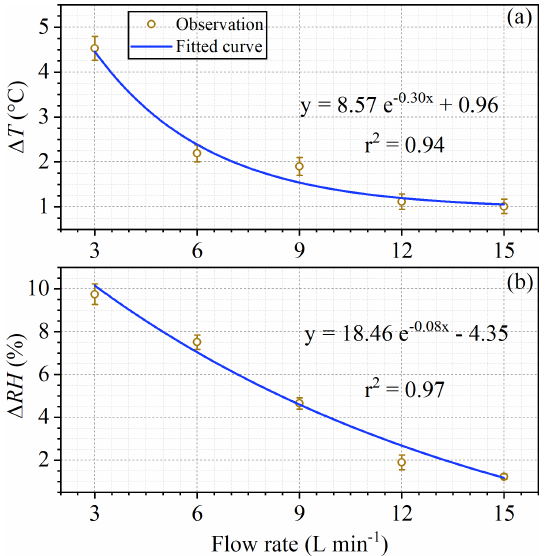
Figure 7. Ambient–enclosure differences in temperature (a) and RH (b) under different flow rates. Circles with errors bars are the measured means and standard deviations. The solid lines are expo- nential fit